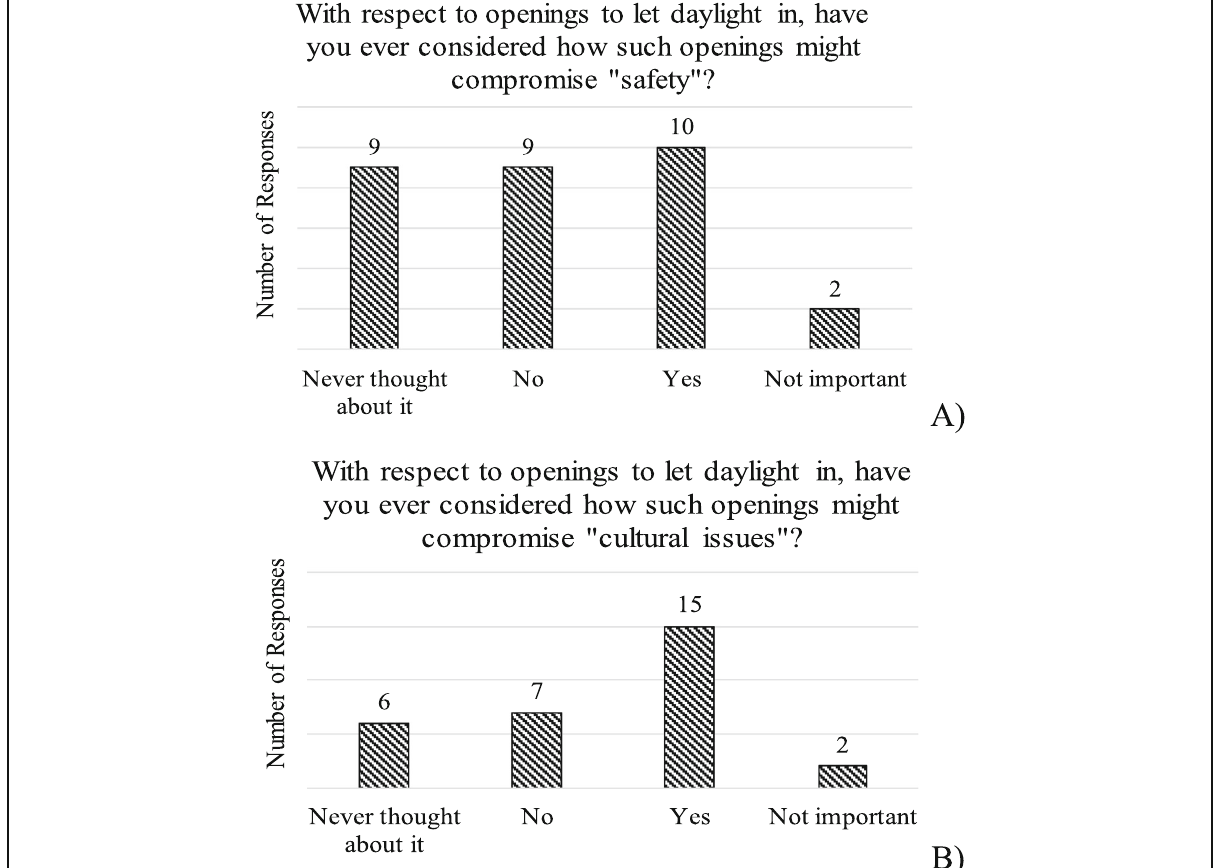
Fig. 4 The effects on cultural and safety issues due to the size and location of